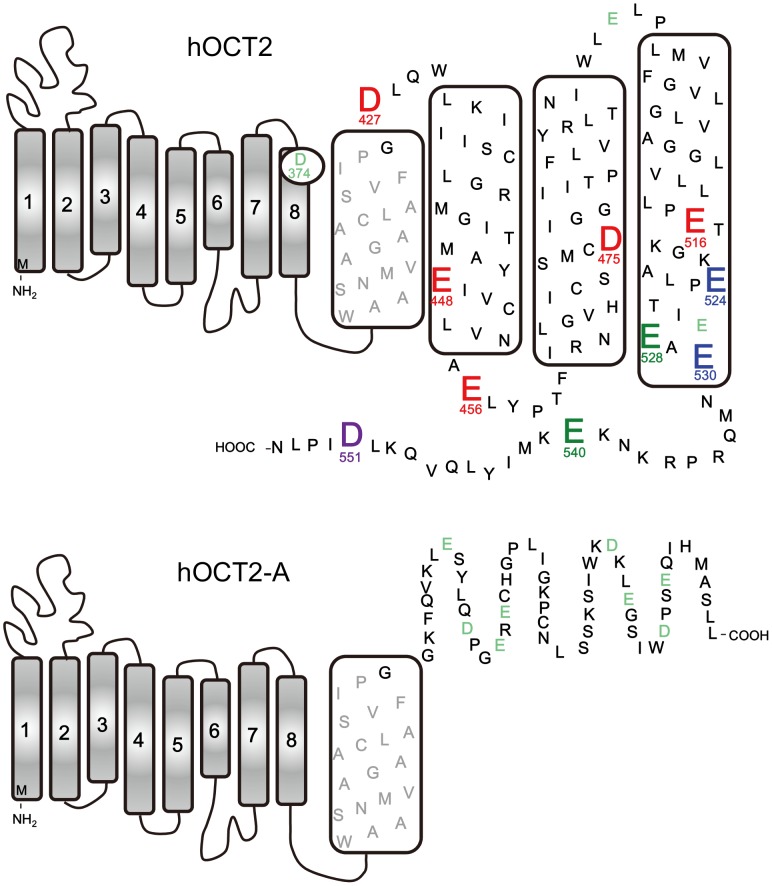
Functional acidic amino acid residues in hOCT2.Putative secondary structure models of hOCT2 and hOCT2-A are shown. Functional acidic amino acid residues in hOCT2 are shown in red, blue, green and violet. Asp427, Glu448, Glu456, Asp475 and Glu516 were involved in putrescine, agmatine and spermidine uptake activity (red), and Glu524 and Glu530 in putrescine and spermidine uptake (blue). Glu528 and Glu540 were involved in putrescine uptake activity (green), and Asp551 in spermidine uptake activity (violet).